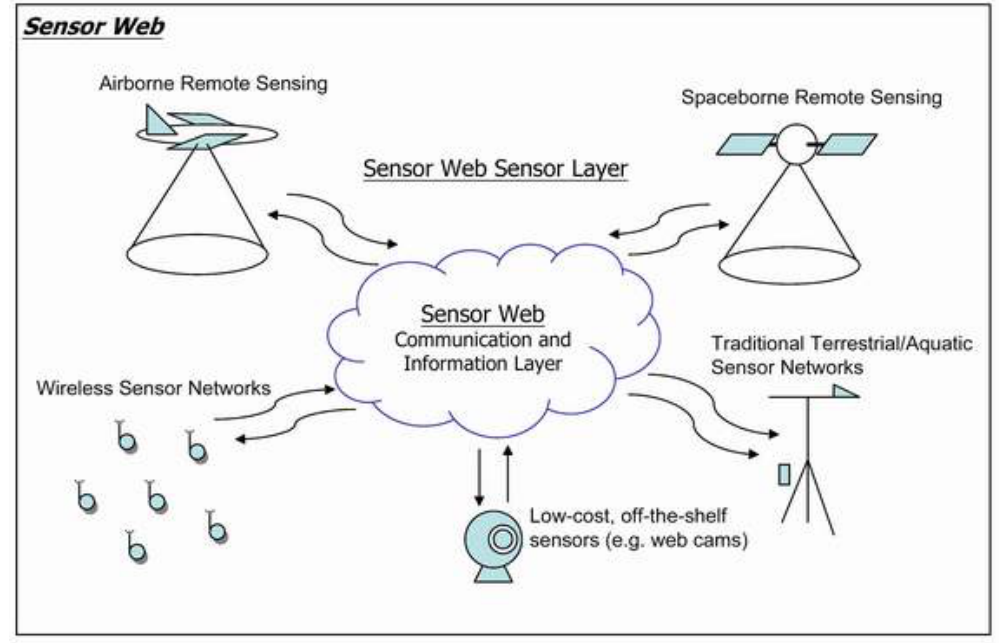
Figure 9. Sensor Web with Inter-communicating Sensors. From Resch et al.